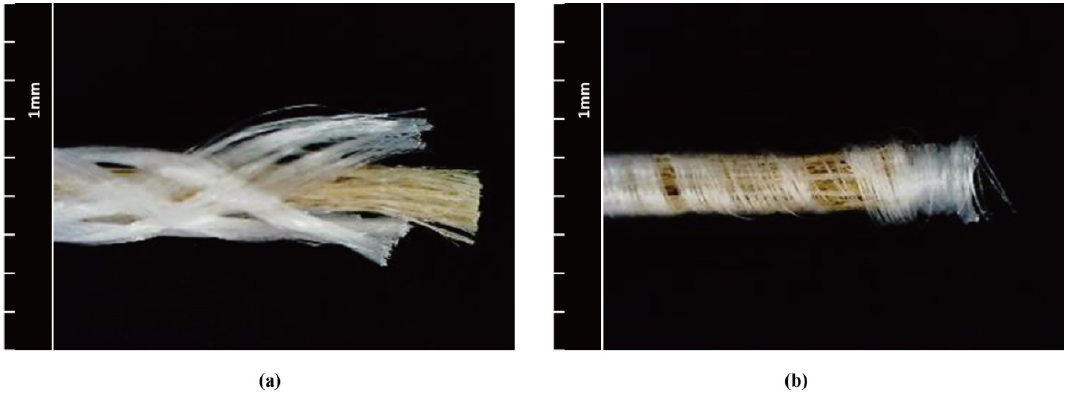
Figure 4. Structural comparison of ( a ) MBY-A vs. ( b ) CWY-B.